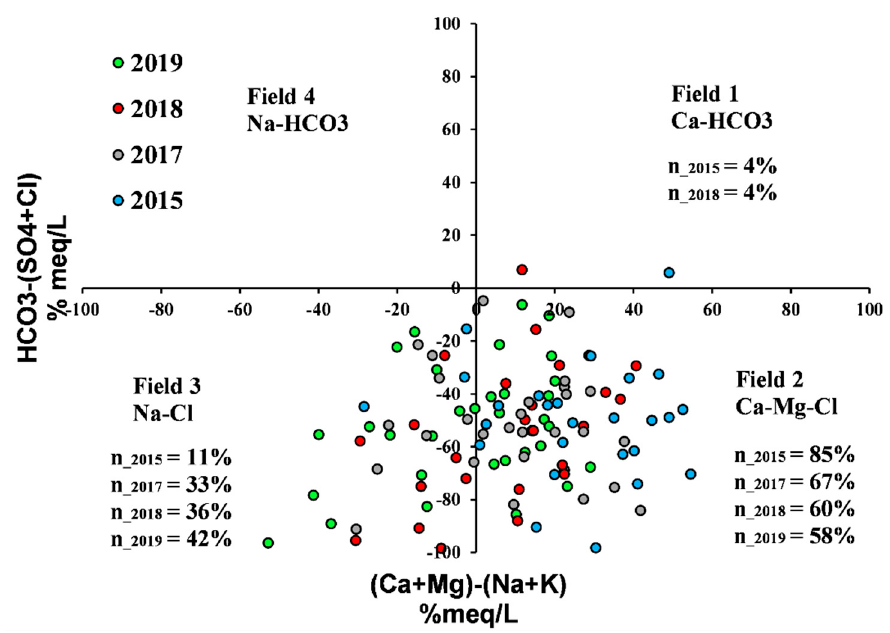
Figure 4. Chadha Diagram for the Groundwater Classification in the Essaouira Basin (2015, 2017, 2018, 2019).